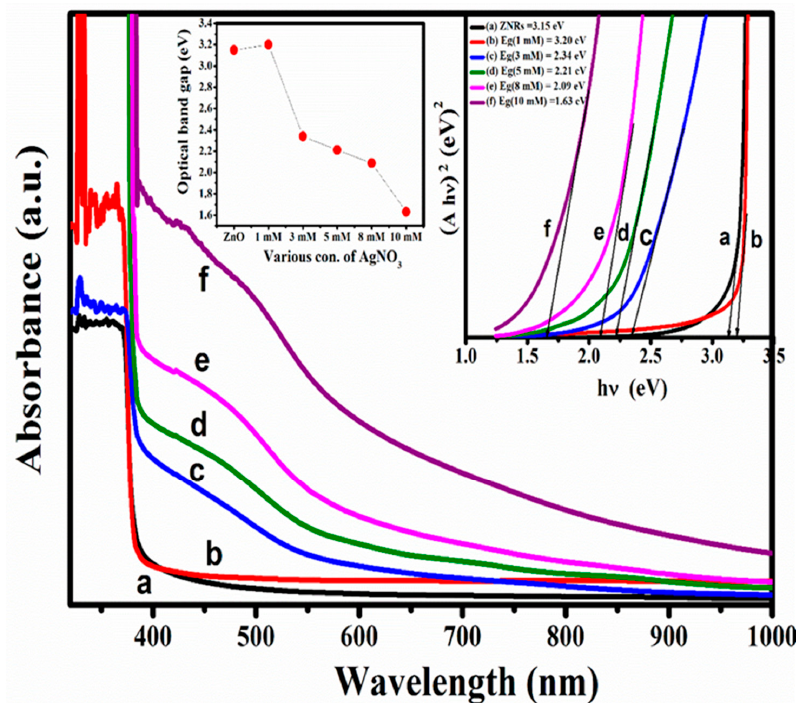
Figure 3. UV-visible spectra and Tauc plot for the direct allowed transitions (presented in insets of the figure) of ZnO NRs/ITO ( a ), and Ag 2 S/ZnO NRs/ITO prepared at various concentrations of AgNO 3 : ( b ) 0.001 M; ( c ) 0.003 M; ( d ) 0.005 M; ( e ) 0.008 M; and ( f ) 0.01 M.